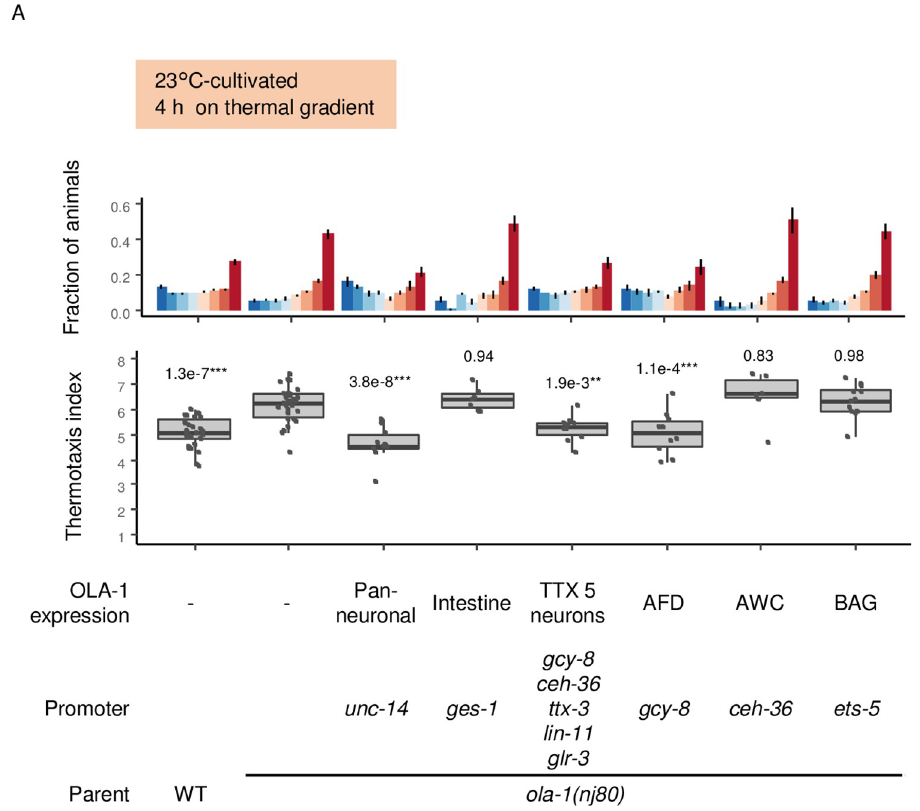
Fig 3. ola-1 acts in AFD thermosensory neurons when animals are cultivated at 23˚C. Wild type and ola-1(nj80) animals and ola-1(nj80) animals that express OLA-1 in cells or tissues indicated were cultivated at 23˚C for 3 days and allowed to freely migrate on a thermal gradient for 4 h. n = 30, 30, 10, 7, 10, 10, 6, 12. p values are indicated (Dunnett test against ola-1(nj80) animals).